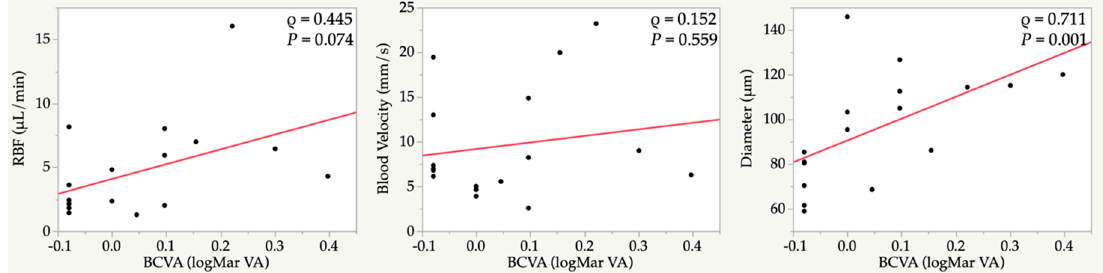
Figure 2. Correlations between the retinal blood flow of the occluded vein and the best corrected visual acuity. RBF, retinal blood flow; BCVA, best corrected visual acuity; ρ , Spearman’s rank correlation coefficient.